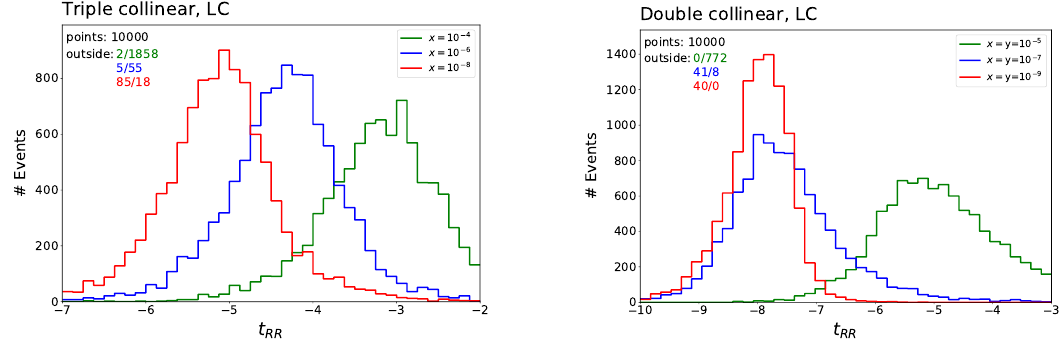
Figure 4 . Test of the double real subtraction term in triple collinear (left) and double collinear (right) limits at leading colour. The subleading colour contribution does not exhibit IR divergences in these limits.